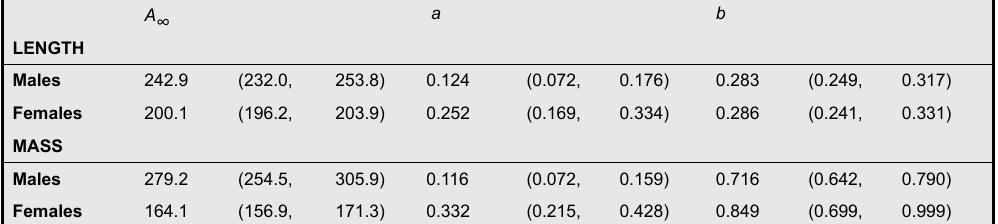
Table 2. Parameter values for von Bertalanffy growth model with 95% confidence intervals in parentheses.